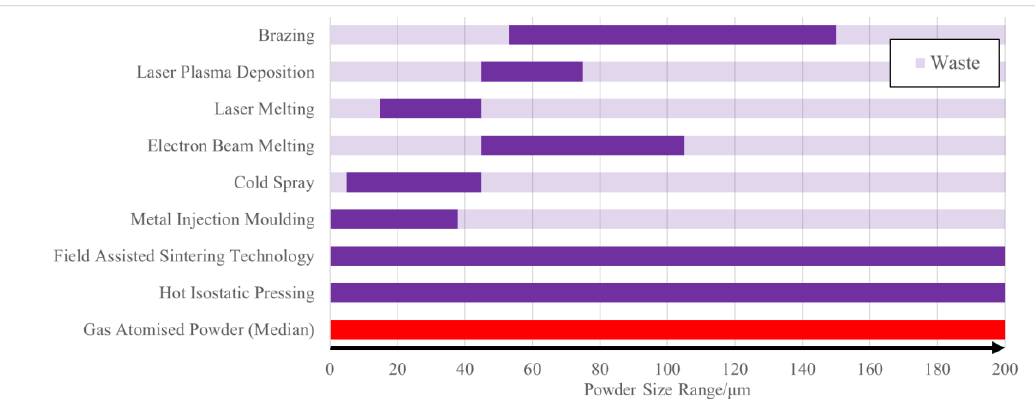
Figure 1. Examples of powder size ranges in powder metallurgy processes using data from References [2,4,5].